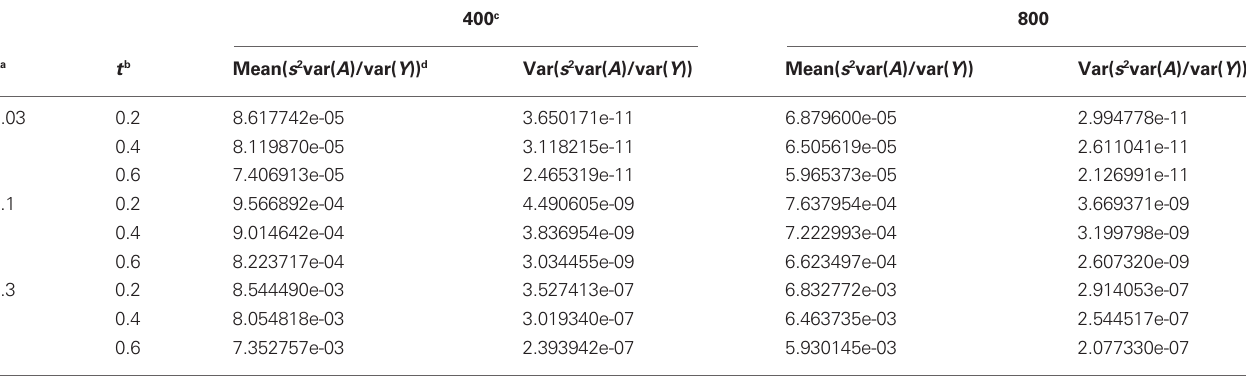
Table A2 | The mean and variance of percent of variability of a quantitative trait explained by admixture under the non-complete null hypothesis. 400 c